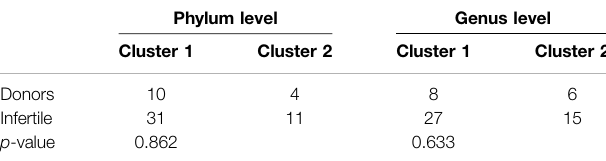
TABLE 1 | Distribution of infertile patients and donors between the two microbiome pro fi les revealed by the clustering analysis based on the bacterial relative abundance both at the phylum and genus taxonomic levels, using the between-groups linkage method based on the Euclidean distance.